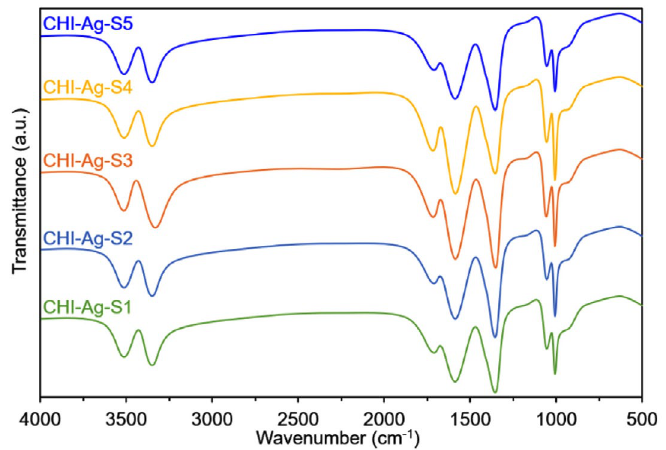
Fig. 8. Typical FTIR profiles of silver nanoparticles loaded Table 3. DMA-mechanical properties of silver and platinum nanoparticles loaded graphene-based bio-composites Bio-composite